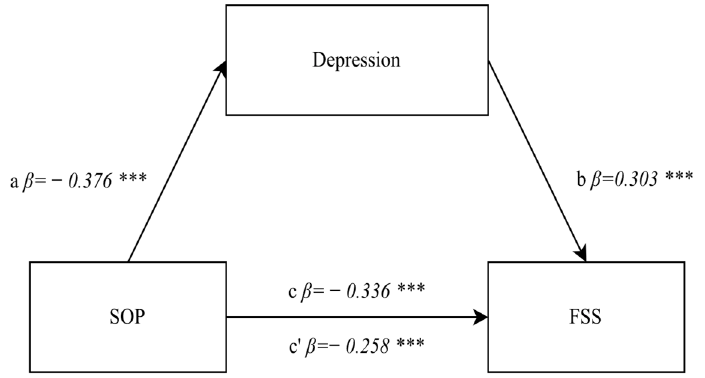
Figure 5. A relationship diagram of the model testing the mediatory effect of anxiety control of the relationship between positive orientation and the degree of tiredness/fatigue. Statistically significant: *** p < 0.001. Explanation: SOP—positive orientation, FSS—fatigue severity scale.